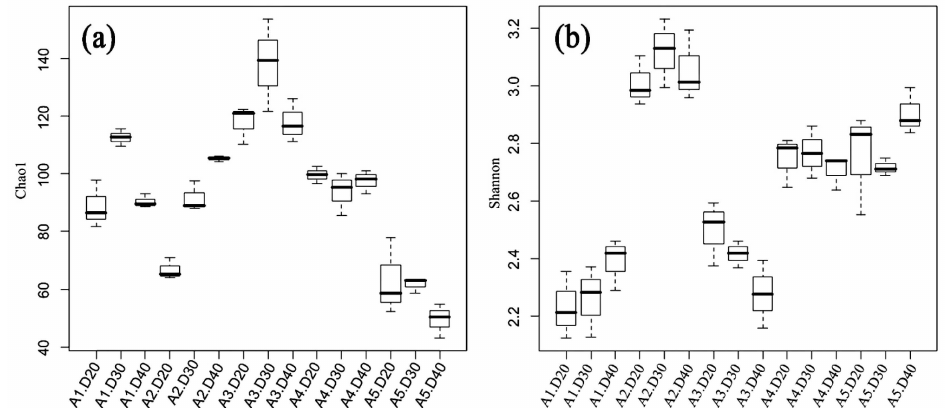
Figure 3. AMF diversity indexes Chao1 ( a ) and Shannon ( b ) for the soil aggregates. Note: A, aggregate size class (A1: >2 mm, A2: 1–2 mm, A3: 0.25–1 mm, A4: 0.053–0.25 mm, A5: <0.053 mm).